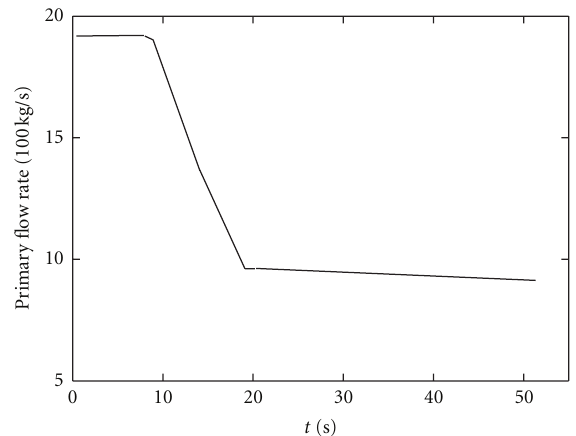
Figure 4: Evolution of the primary flow rate showing the e ff ect of the primary pumps failure during event